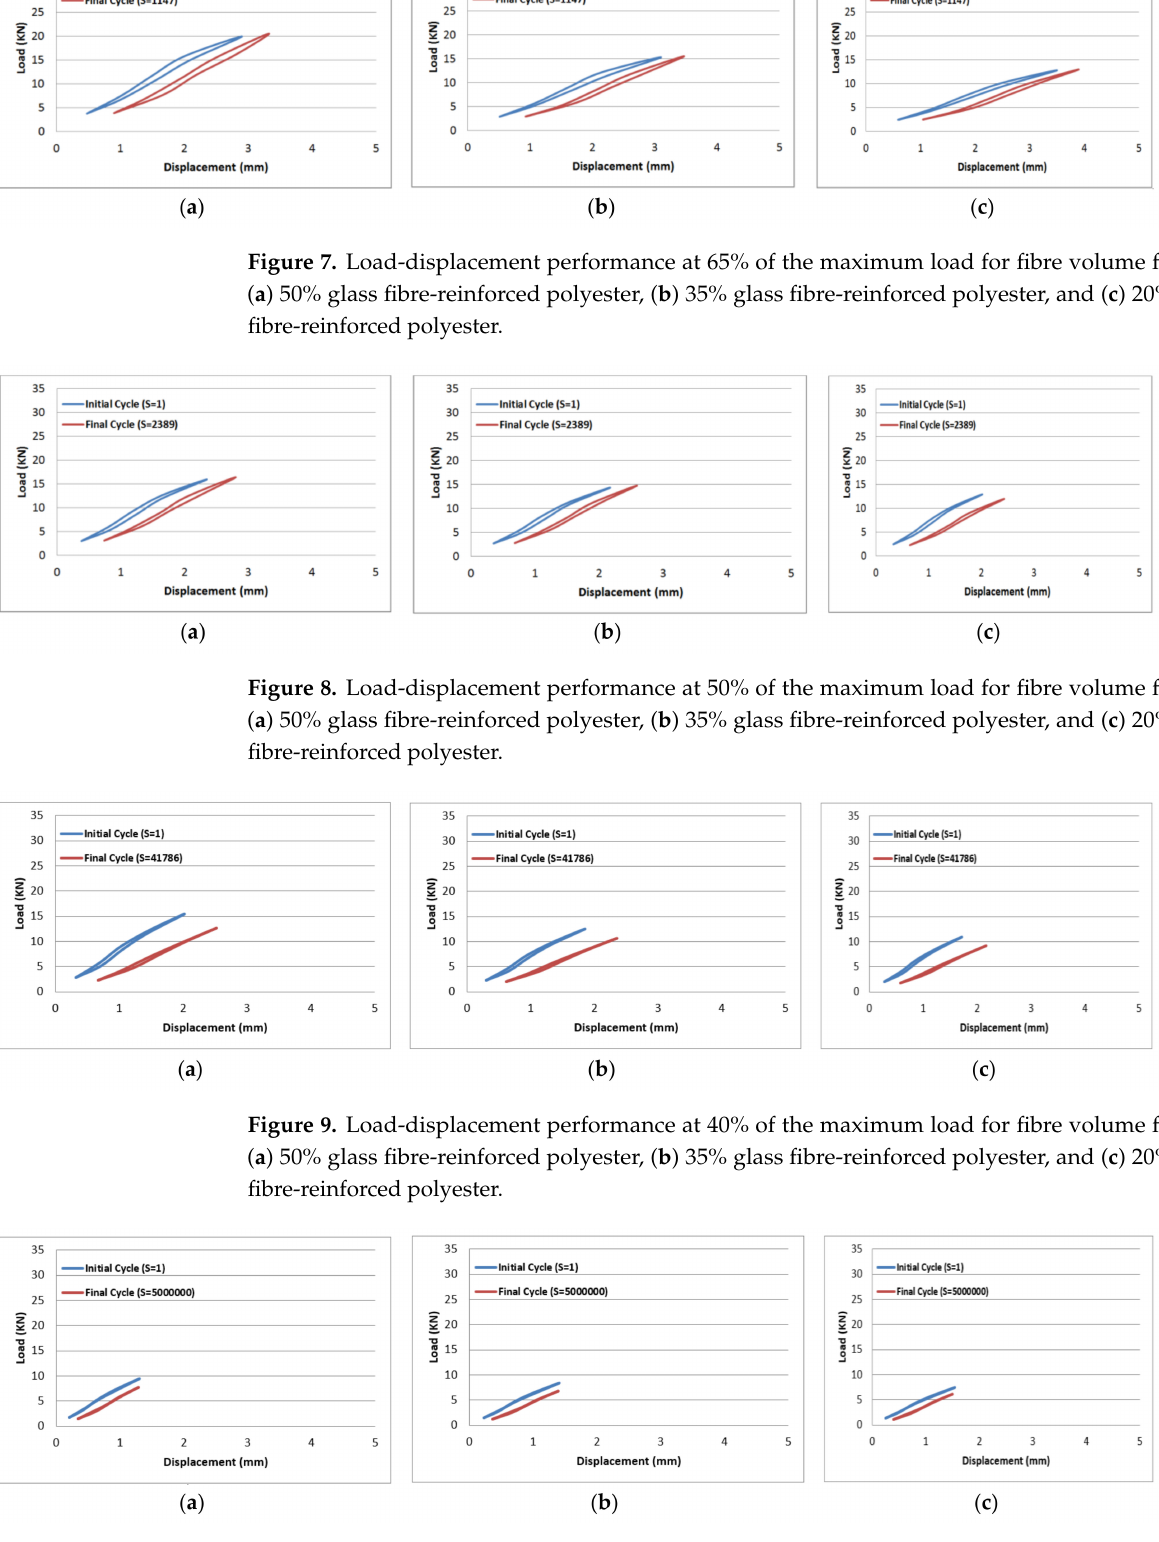
Figure 10. Load-displacement performance at 25% of the maximum load for fibre volume fraction ( a ) 50% glass fibre-reinforced polyester, ( b ) 35% glass fibre-reinforced polyester, and ( c ) 20% glass fibre-reinforced